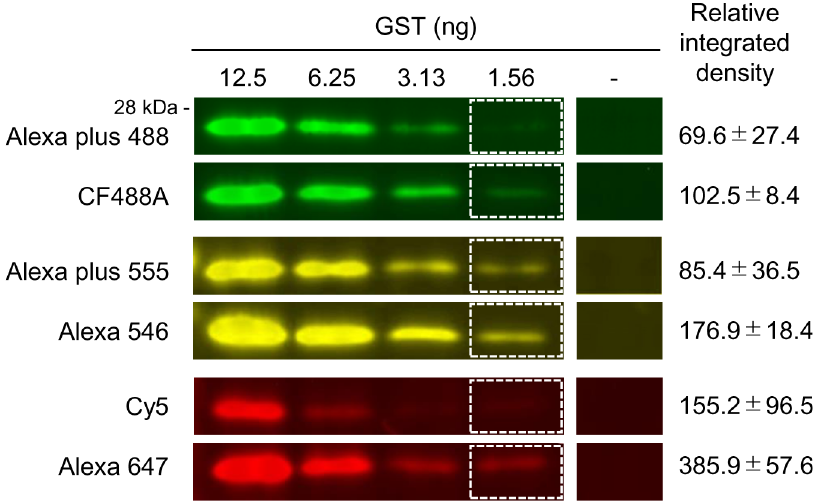
Fig 3. Increase in signal intensity by selecting appropriate fluorescent dyes. Comparison of detection sensitivity among fluorescent dyes. Joined images of dilution series of GST and background area are shown. GST was detected by anti-GST antibody, fluorescent dye conjugated to secondary antibody, and narrow-band filters (Em: 500–520 nm, 570–590 nm, and 665–715 nm). Relative integrated density of 1.56 ng GST signal is shown (mean ± standard error of three independent experiments). Exposure time was 1/1.5 seconds, 1/3 seconds and 1 second in green, yellow and far- red wavelength regions respectively.